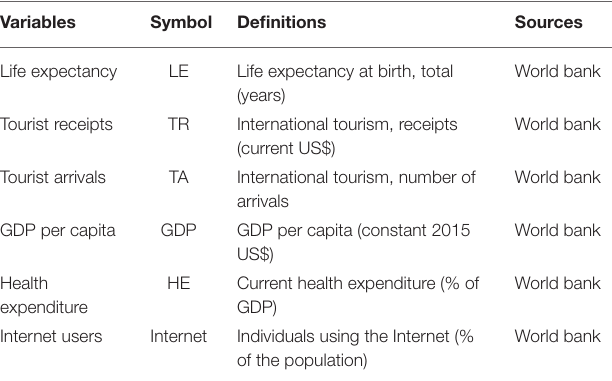
TABLE 1 | Variables definition and